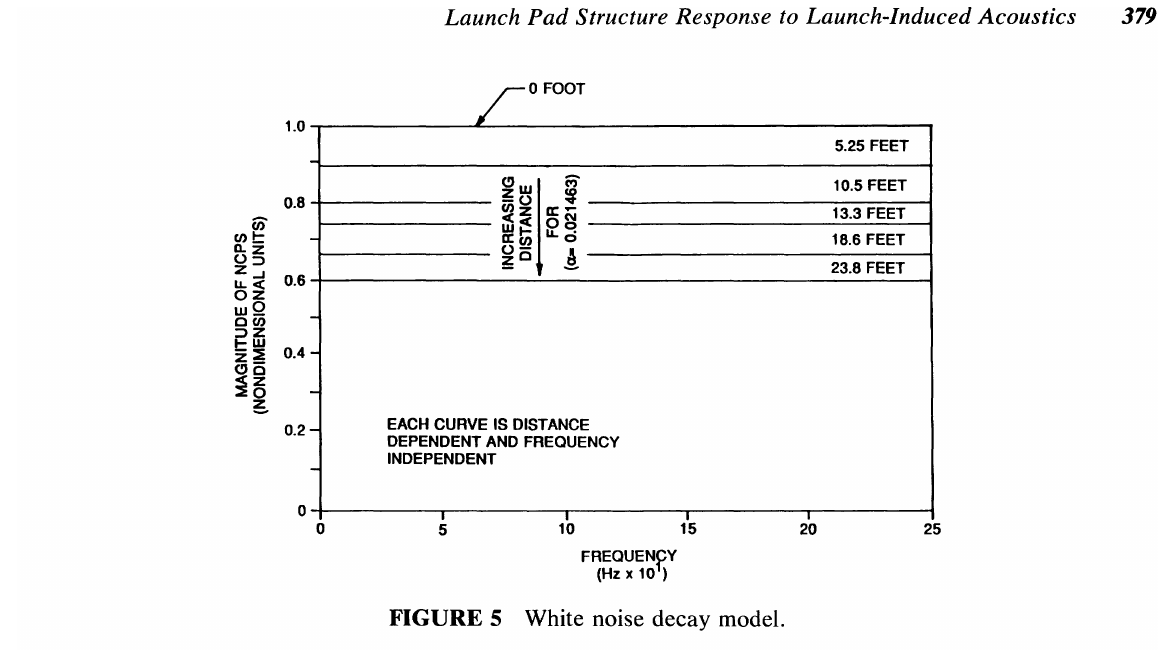
FIGURE 5 White noise decay model.